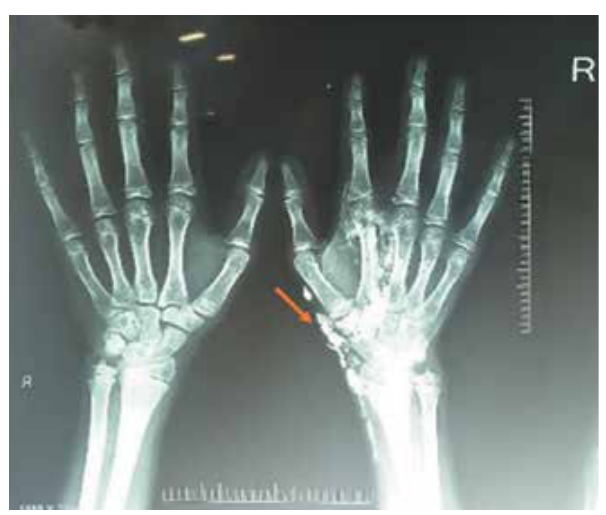
Fig 6. X-ray of both hands revealing calcinosis cutis